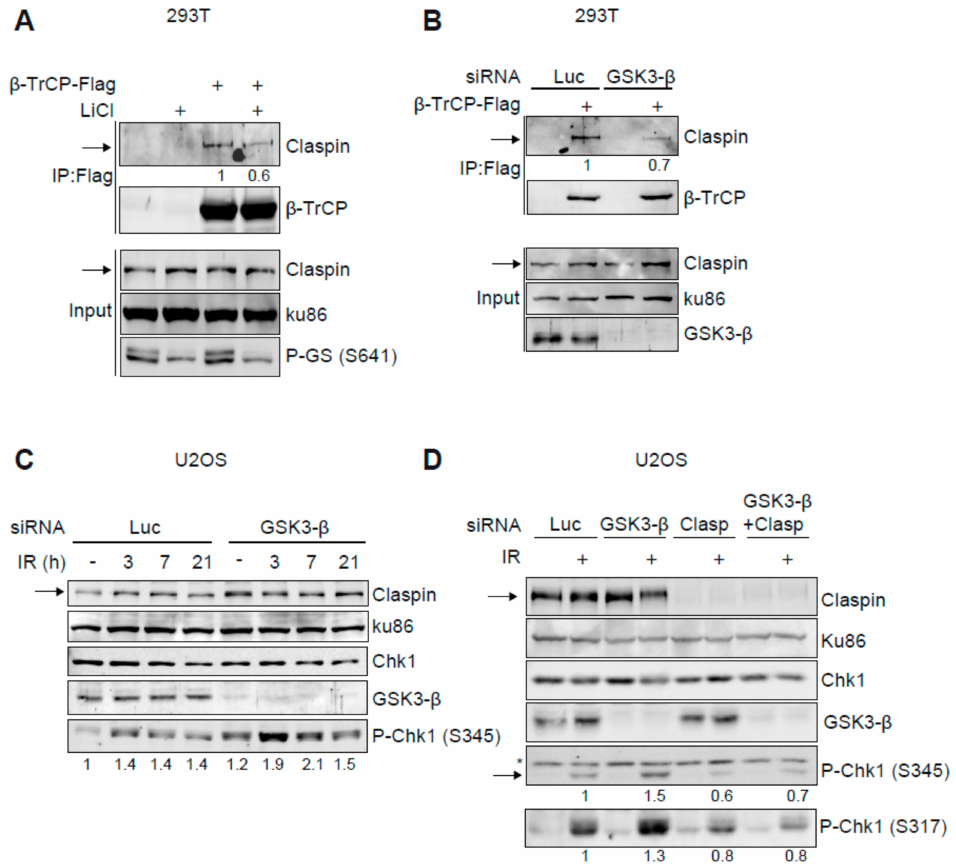
Figure 3. GSK3- β controls the Claspin- β -TrCP interaction and Chk1 activation. ( A , B ) 293T cells, transfected with HA-Claspin and β -TrCP-Flag were lysed, after which anti-Flag immunoprecipitations were analysed by Western blot with the indicated antibodies. In ( A ) cells were treated with 20 mM LiCl for 3 h before collection when indicated. In ( B ) 293T cells were depleted for Luc or GSK3- β by siRNA before plasmid transfection. ( C ) U2OS cells were downregulated for Luc or GSK3- β . 48 h post-transfection, cells were treated with IR (3Gy) and harvested at the indicated time points. Western blot analysis with the indicated antibodies. ( D ) U2OS cells were incubated with the indicated siRNAs for 48 h before irradiation (3Gy). 3 h after irradiation, extracts were made and analysed using the indicated antibodies. Ku86 was used as a loading control. P-Chk1 (Ser 317 or Ser345) stands for the phosphorylated forms of Chk1 on Serines 317 or 345, respectively. Arrows indicate Claspin, and in ( D ) also the specific band of Chk1 phosphorylated at Serine 345. Asterisk in ( D ) shows an aspecific band. Quantifications of phospo-Chk1 signal comparing to total Chk1 levels are shown below each panel